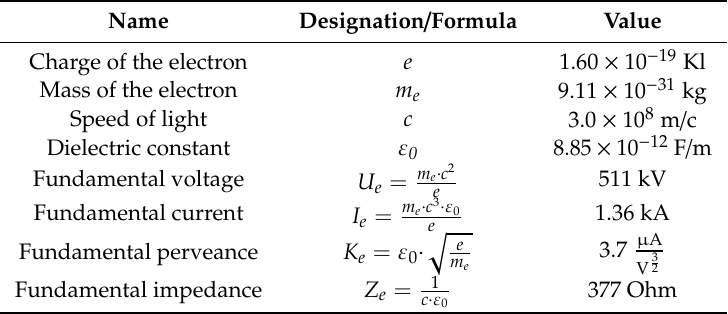
Table 3. Values for fundamental normalization.